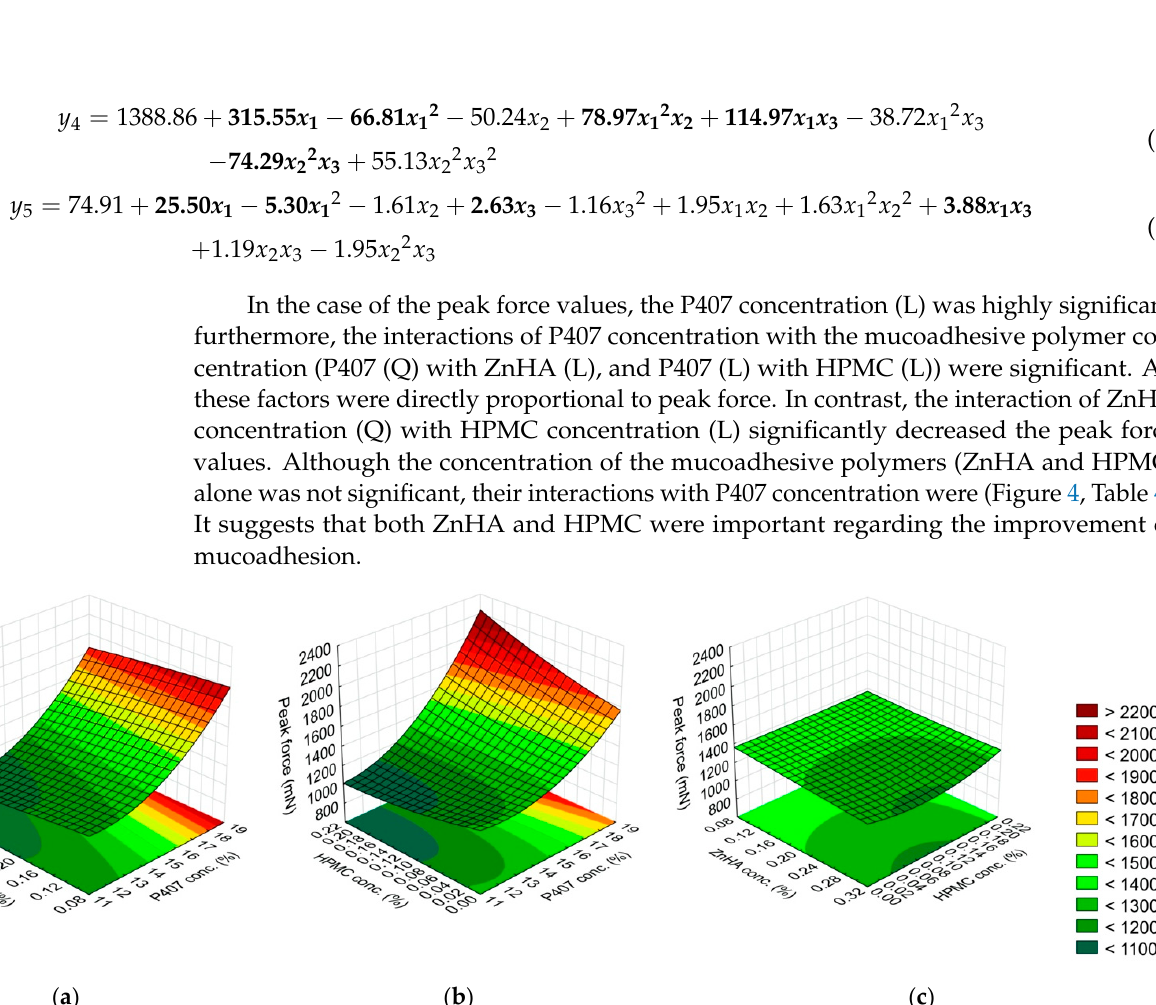
Figure 5. Effect of the composition on the adhesive work: ( a ) P407 and ZnHA concentrations, ( b ) P407 and HPMC concentrations, ( c ) ZnHA and HPMC; (the 3rd factor is at 0 level in each case).